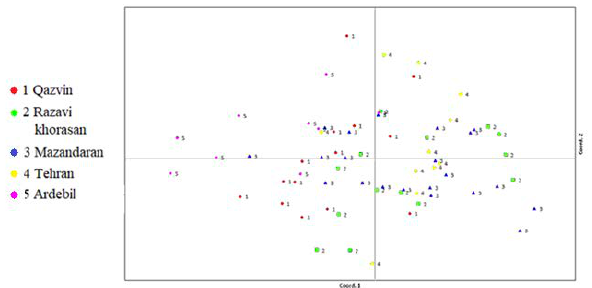
Figure 3. PCO plot of Ziziphora clinopodioides provinces based on ISSR data.